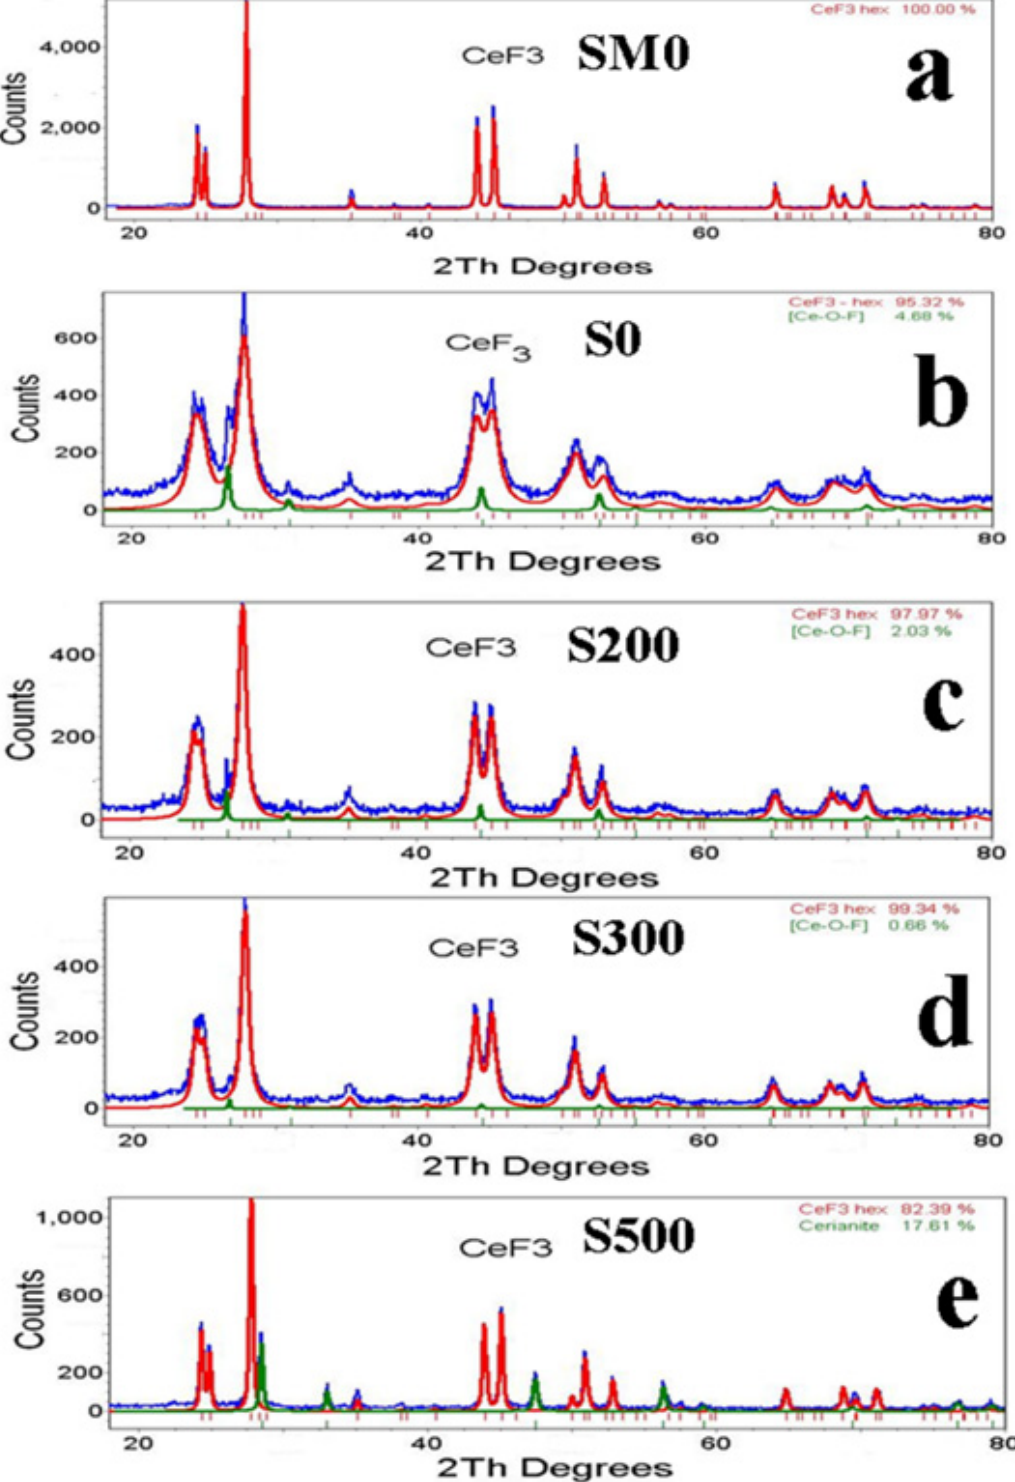
Figure 2. XRD pattern of unannealed (micro and nano powders) ( a , b ) and CeF 3 powders air annealed at 200, 300 and 500 °C ( c – e ).